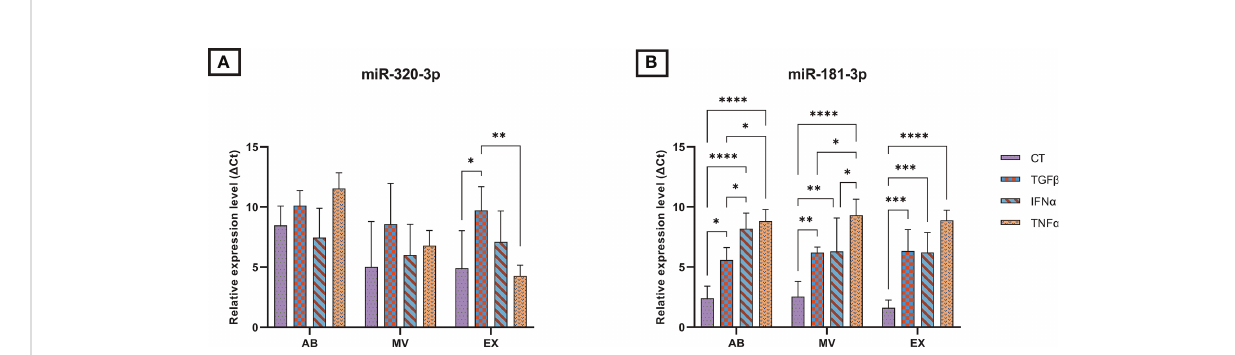
FIGURE 2 The relative expression of microRNAs in three EV populations in control and inducing groups. The miRNA expression levels in EVs are represented by D Ct values with 7.5 ng cDNA input and were normalized to the secreted cells (UCMSCs). The relative expression level in different EV sub-populations of (A) miR-320a-3p; (B) miR-181b-3p. Cytokines priming suppressed the selective sorting of miR-181b-3p but not miR- 320a-3p into UCMSC-derived EVs. AB: Apoptotic bodies; MV: Microvesicles; EX: Exosomes. CT-AB/MV/EX: AB/MV/EX secreted from non- priming UCMSCs; TGF b -AB/MV/EX: AB/MV/EX secreted from TGF b -primed UCMSCs; IFN a -AB/MV/EX: AB/MV/EX secreted from IFN a -primed UCMSCs; TNF a -AB/MV/EX: AB/MV/EX secreted from TNF a -primed UCMSCs. Results were averages of 3 biological samples (n = 3). Statistical signi fi cance was determined by Two-Way ANOVA and indicated by: * where p < 0.05; ** where p < 0.01; *** where p < 0.001; **** where p < 0.0001. Error bars indicate ±